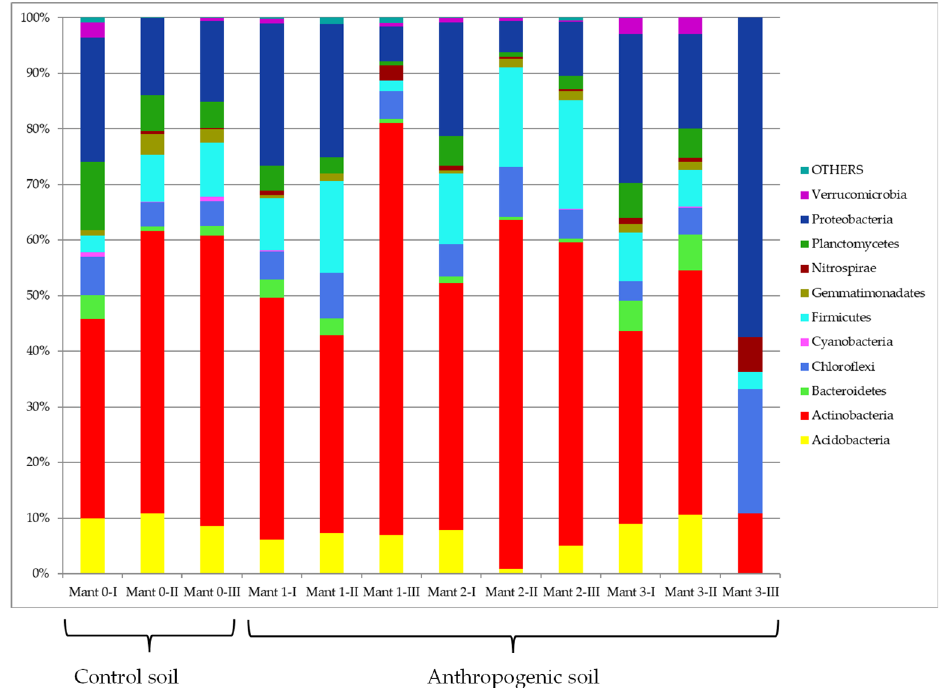
Figure 4. Relative abundances (%) of bacterial phyla identified by MiSeq Illumina in soil samples. Abbreviations are as follows: Soil samples: Mant 0, control soil (original Vertisol not affected by pedotechnics), while Mant 1, Mant 2 and Mant 3 represent the anthropogenic soils of sites 1 to 3. Depths: I, 0–10 cm; II, 10–30 cm; and III, 30–50 cm.